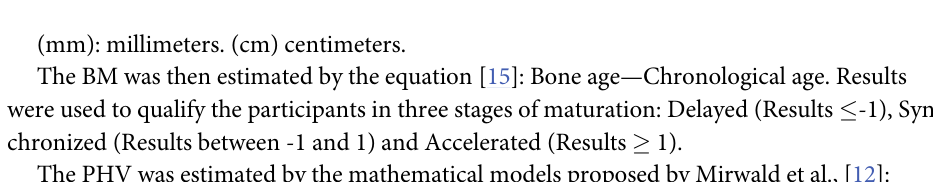
scale with an accuracy of 0.1 kg (FILIZOLA 1 , S ã o Paulo, Brazil). Height and sitting height (trunk length) were assessed using a stadiometer with an accuracy of 0.1 cm (SANNY 1 , S ã o Paulo, Brazil). Leg length was calculated by subtracting trunk length from height [12]. The perimeter (biceps) was measured using an anthropometric tape (SANNY 1 , S ã o Paulo, Brazil), the bone diameters (Humerus and femoral) were measured using a caliper (SANNY 1 , S ã o Paulo, Brazil), and skinfold (triceps) was measured by a scientific skinfold caliper (SANNY 1 , S ã o Paulo, Brazil).